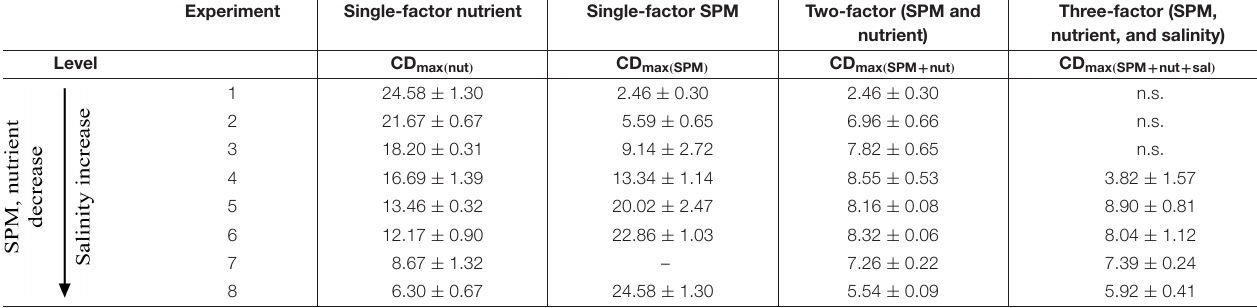
TABLE 2 | The maximum cell density (CD max , 10 4 cells/mL, mean ± standard deviation) of A. carterae under different culture settings in the four experimental groups.